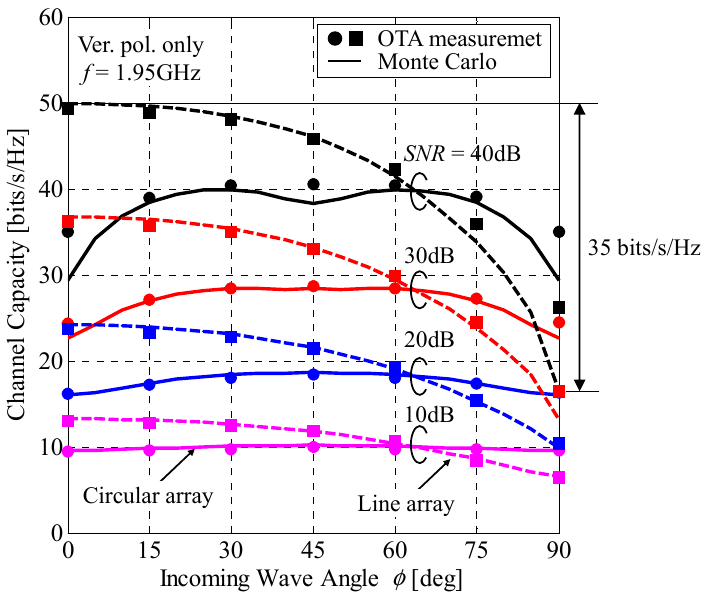
Figure 16. 4 × 4 MIMO channel capacity as a function of the incoming wave angle.